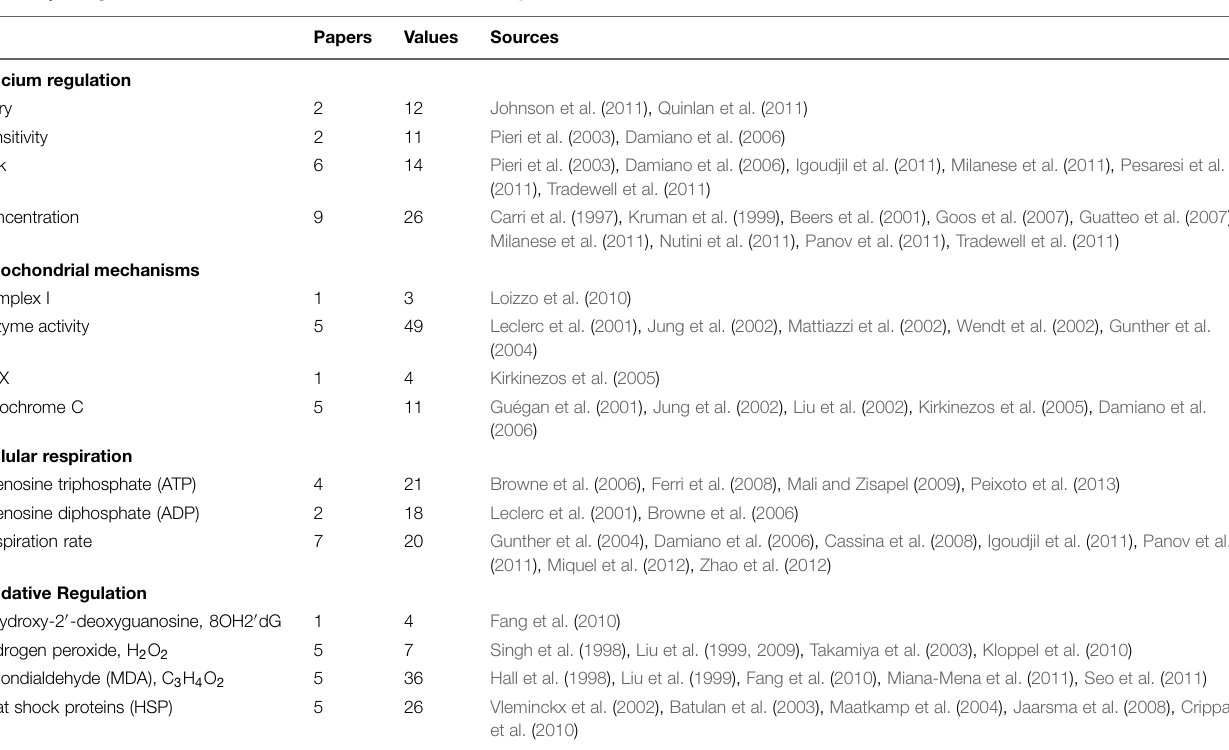
TABLE 1 | Categorization, distribution, and sources of included experimental